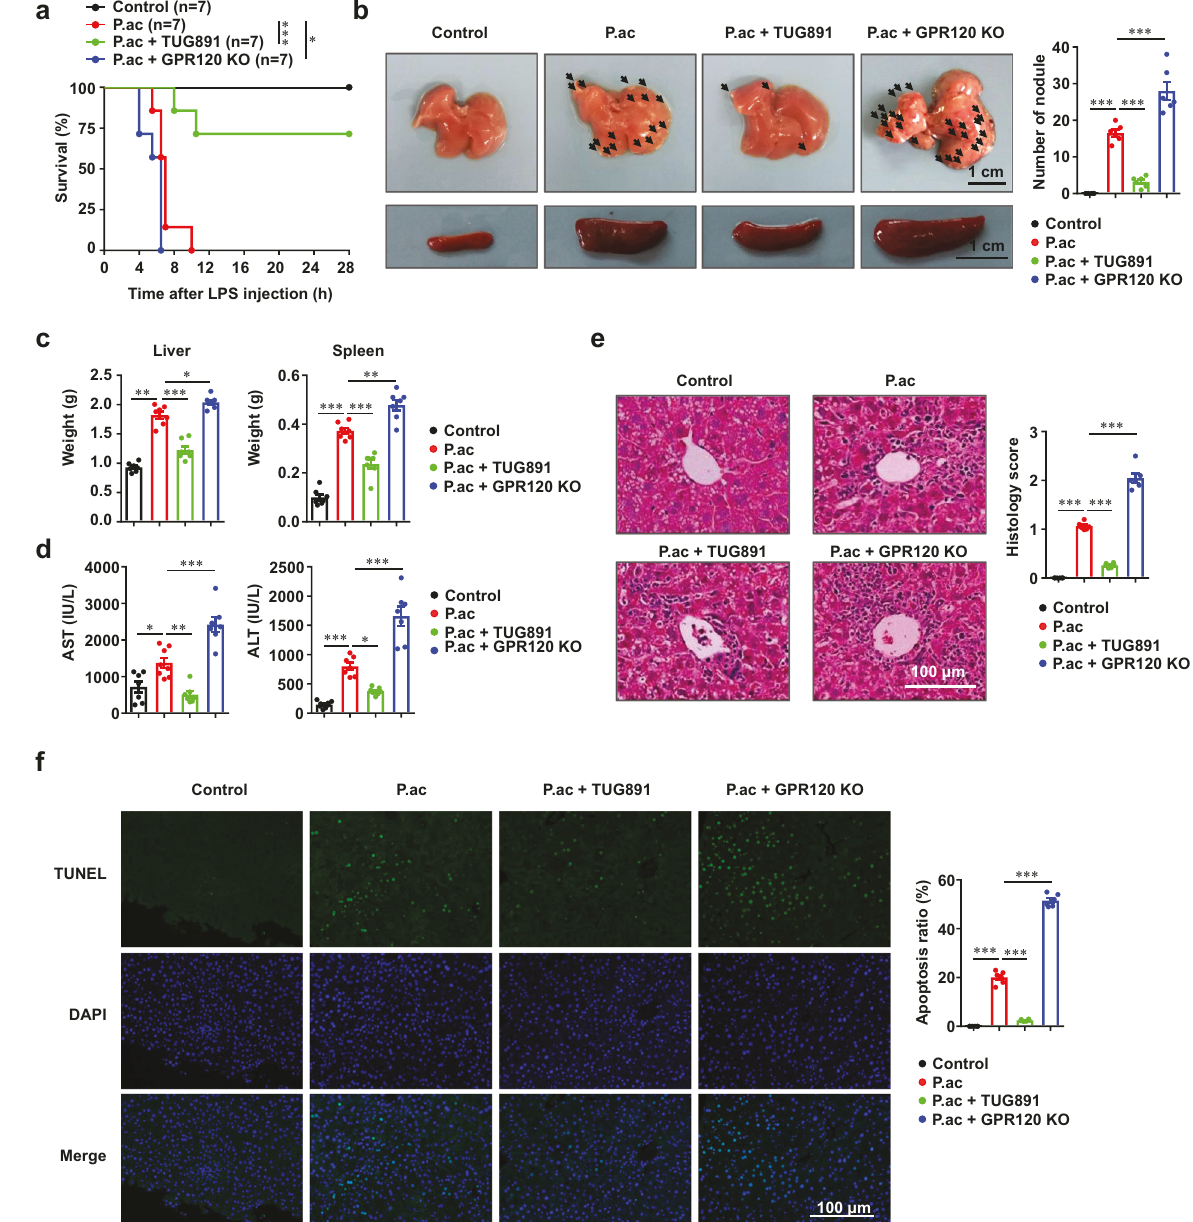
Fig. 1 Lack of GPR120 exacerbated, whereas activation of GPR120 ameliorated, the severity of bacteria-induced liver injury. Wild-type (WT) and GPR120 − / − (GPR120 KO) mice were injected with P. acnes (P.ac) suspended in 100 μ L of PBS. Vehicle or TUG891 (10 mg/kg) was administered i.p. to WT primed mice on days 0, 2, 4, and 6 ( n = 7 mice per group). a One microgram of LPS in 100 μ L of PBS was injected into all P. acnes -primed mice on day 7 to aggravate FHF. Cumulative survival rates were analyzed. b Liver and spleen tissues were isolated and photographed. Representative images from one of three experiments were shown. c The weights of livers and spleens from the four groups was measured. d Serum was collected on day 7, and the levels of ALT and AST were measured. e Liver tissues were sectioned for histological examination and semiquantitative analysis of in fl ammatory conditions in the liver were shown. Scale bar, 100 μ m. f Frozen sections of livers were used for TUNEL staining. Scale bar, 100 μ m. The results are representative of three to six independent experiments and presented as the mean ± SEM. Signi fi cant differences were analyzed by Log-rank test ( a ), One-way ANOVA ( b – f ). * p < 0.05, ** p < 0.01, *** p < 0.001. GPR120 inhibited CD4 + T cell responses in bacteria-induced mice showed fewer nodules, less in fi ltration of lymphocytes, and lower level of hepatocyte apoptosis than P. acnes -primed mice liver injury mice (Figs. 1e and f). Taken together, these data demonstrated that the It has been reported that CD4 + T cell-mediated in fl ammation lack of GPR120 exacerbated liver injury, while TUG891 treatment plays a major role in P. acnes -induced liver injury [26 – 28]. We effectively attenuated the severity of bacteria-induced liver injury therefore investigated T cell in fi ltration in liver and spleen after P . acnes priming. After treatment with TUG891, the absolute number and improved the survival rate of FHF mice.